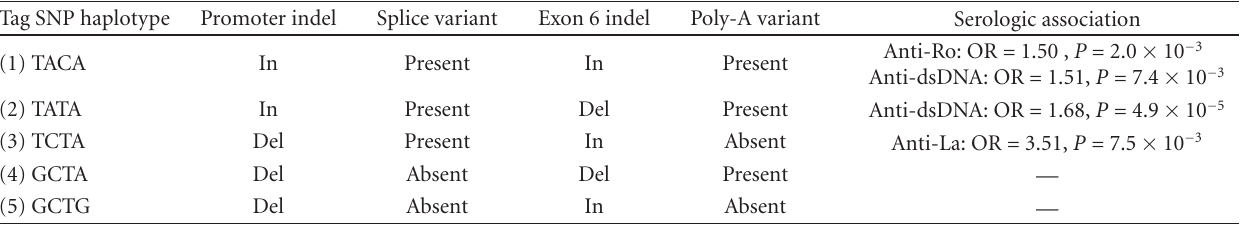
Table 2: European ancestry case-case analysis showing IRF5 haplotypes with associated functional elements and serological associations